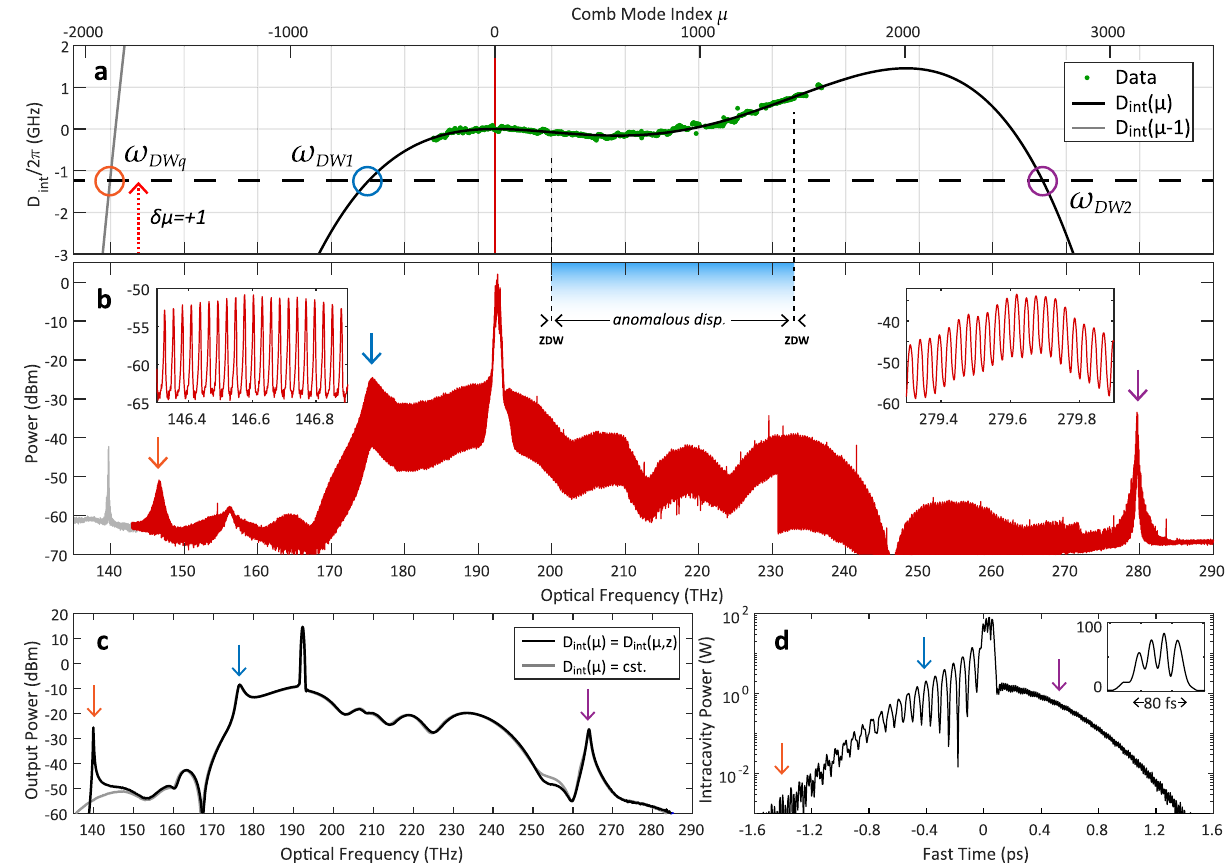
Fig. 5| Octavespanning zero-dispersionsolitonspectrum, MR1. a Experimental measurementofthe resonatorintegrated dispersion D int , along with the spectrally extended fi tted solution, and solution shifted by+ D 1 . Pump frequency (and pump detuning) marked by the vertical red line (horizontal dashed line). Phase-matched locations of dispersive waves marked by circles, with momentum mismatch in dotted red arrow. b Measured spectrum of ZDS (4) , with dispersive waves marked